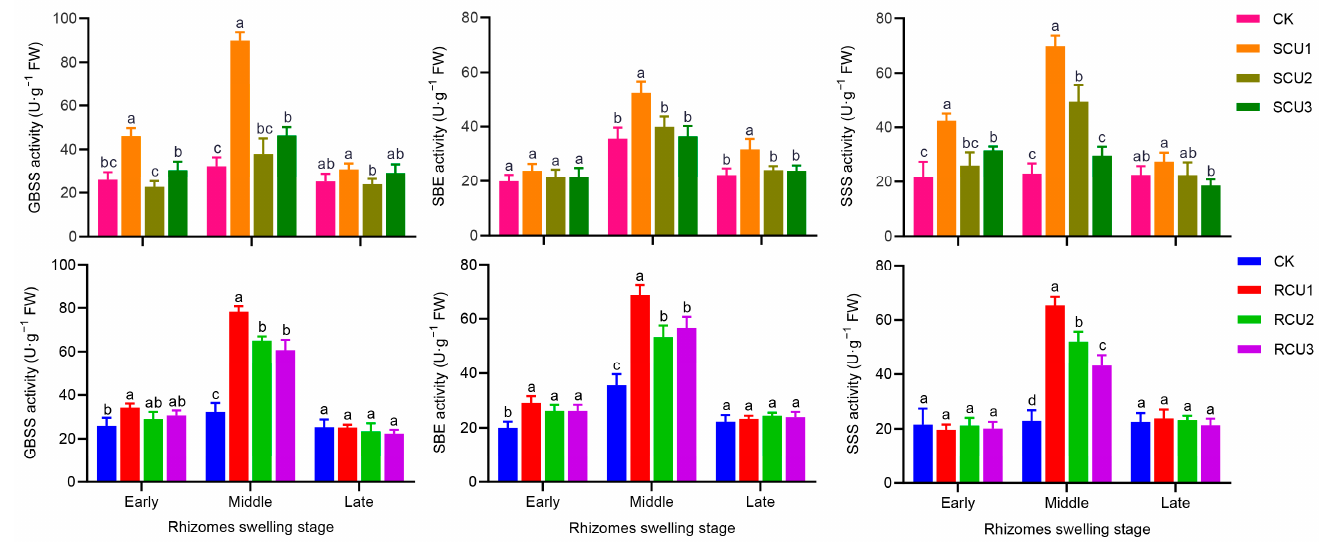
Figure 5. The activity of starch biosynthesis enzyme under SCU and RCU treatments. Different letters indicate a significant difference in starch biosynthesis enzyme activity at the swelling stage of the lotus rhizome between different treatments at the 5% level. Error bars show SD from three biological replicates.